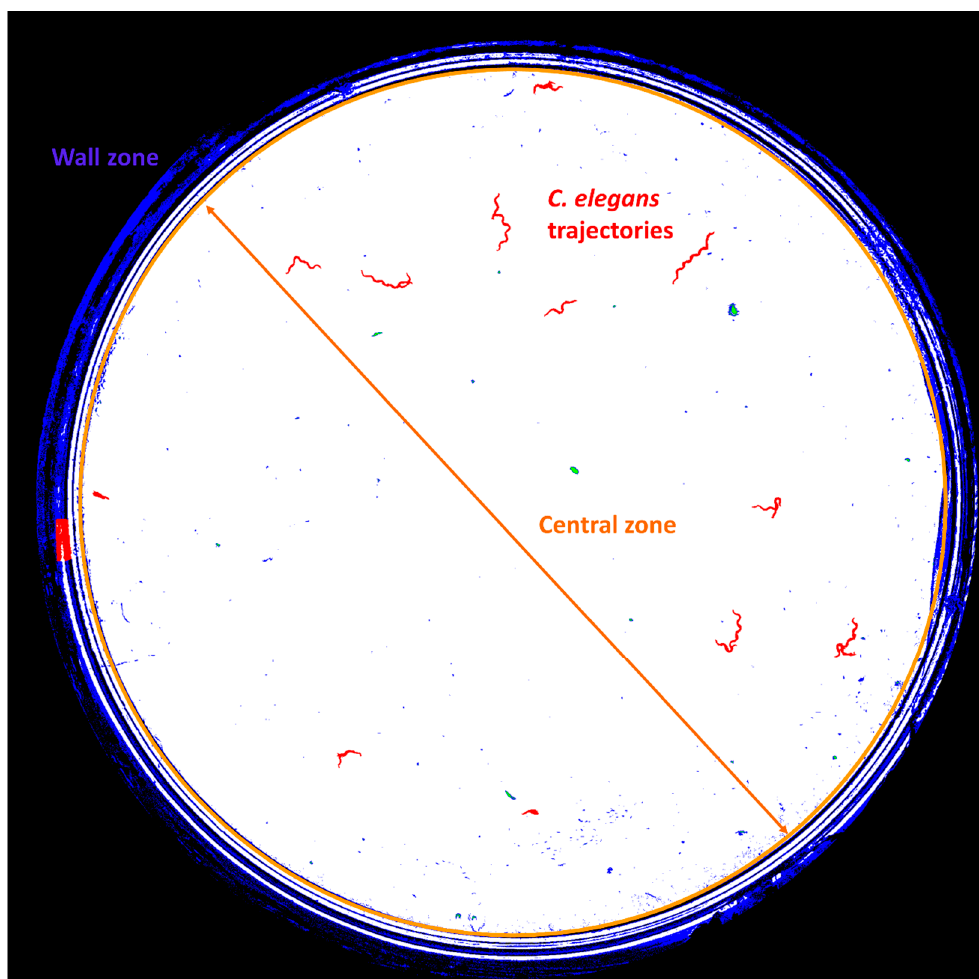
Figure 2. Result of the processing of the captured sequence. The orange circle delimits the central zone and the wall zone. In red are the trajectories of C. elegans .